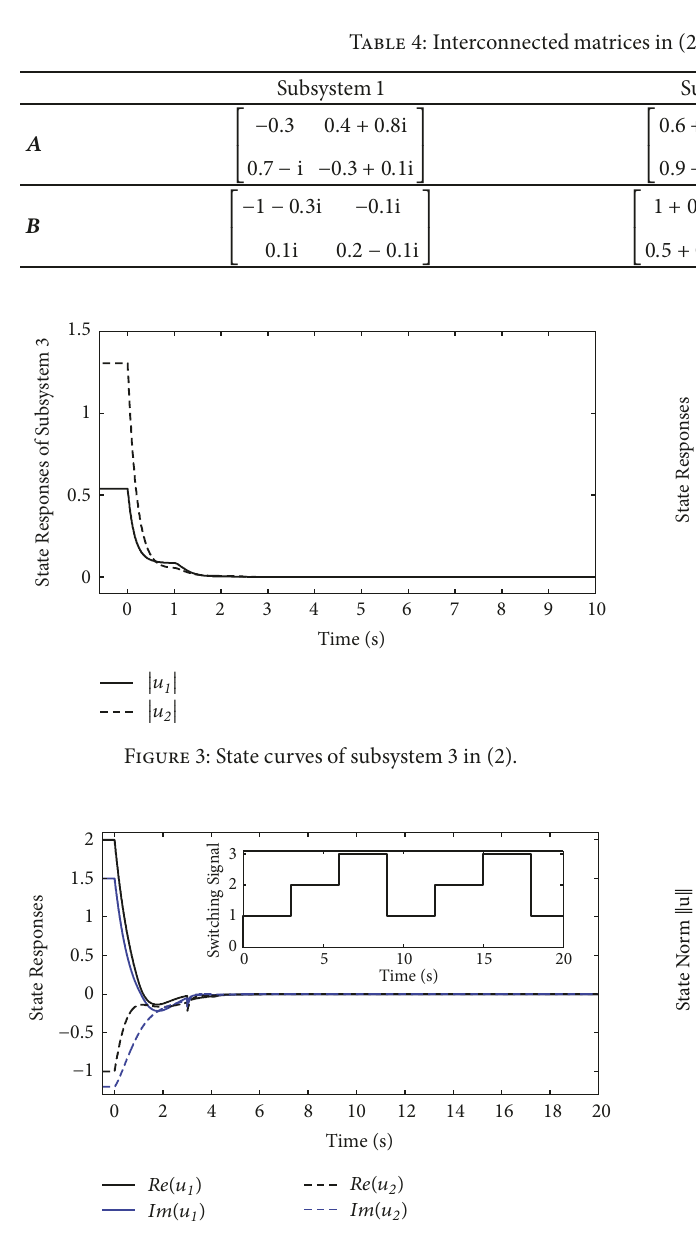
Figure 4: Real part curves and imaginary part curves of system (2).